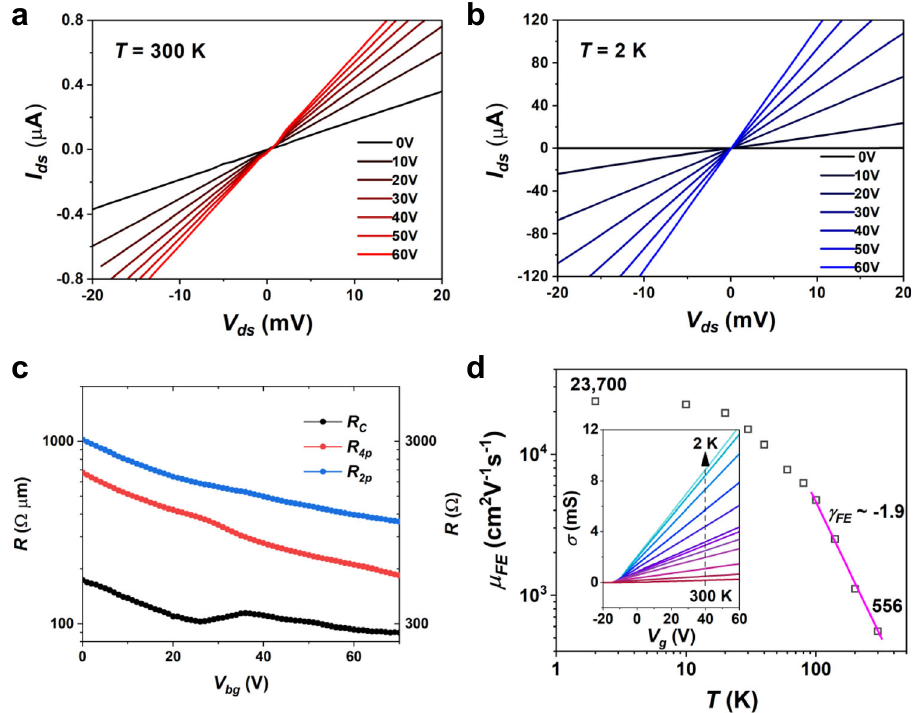
Fig. 4 Electrical performance of the 3L-MoS 2 FET utilizing LBD contacts. Two-probe I ds – V ds curves at ( a ) room temperature and ( b ) 2 K, respectively. c Contact resistance, R c , extracted from the resistance difference between two-probe and four-probe measurements as the function of gate voltages, where the four-probe resistance is scaled by L out as described in the Methods section and both resistance values in Ω · μ m and Ω units are plotted in the logarithmic L in scale. It can be seen that the contact resistance depends little on the back gating after the device is fully turned on. The off-state of this device locates below − 10 V back-gate voltage due to the natural electron doping of MoS 2 as demonstrated in the inset of Fig. 4d. d Temperature-dependent fi eld-effect mobility, μ FE , derived from the channel conductance as the inset shows, showing the strong phonon scattering effects of 3L-MoS 2 at high temperatures. γ FE represents the exponential temperature decay constant of the fi eld-effect